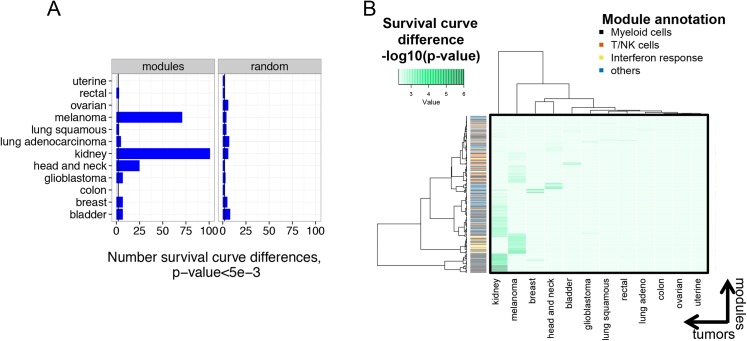
Immune gene expression in tumors predicts patient survival in some but not all tumor types.A) Numbers of immune molecular modules predicting survival varies between tumor types. Tumors were partitioned into equal sized groups by median gene expression of each of 526 immune molecular modules (Experimental Procedures). Shown are numbers of modules that significantly predicted survival of patients with each of twelve different tumor types (p-value<5e-3). The numbers of random partitions that yielded significant survival curve differences for each tumor are shown for comparison (N = 526 permutations). At this p-value, ~2 partitions would be expected to yield significant survival curve differences by chance (vertical lines). B) Qualitative differences in the spectrum of modules yielding significant survival curve differences in different tumors. The heatmap displays different tumor types on the x axis versus the identities of molecular modules that gave significant survival curve differences in any tumor type at p-value <5e-3 (N = 229) on the y axis (S3 Table). The green color intensity indicates the significance of differences in survival curves (-log10 (p-value)). The color bar indicates the summary annotation term for each module on the y axis. Clustering was performed in both the x and y dimensions.